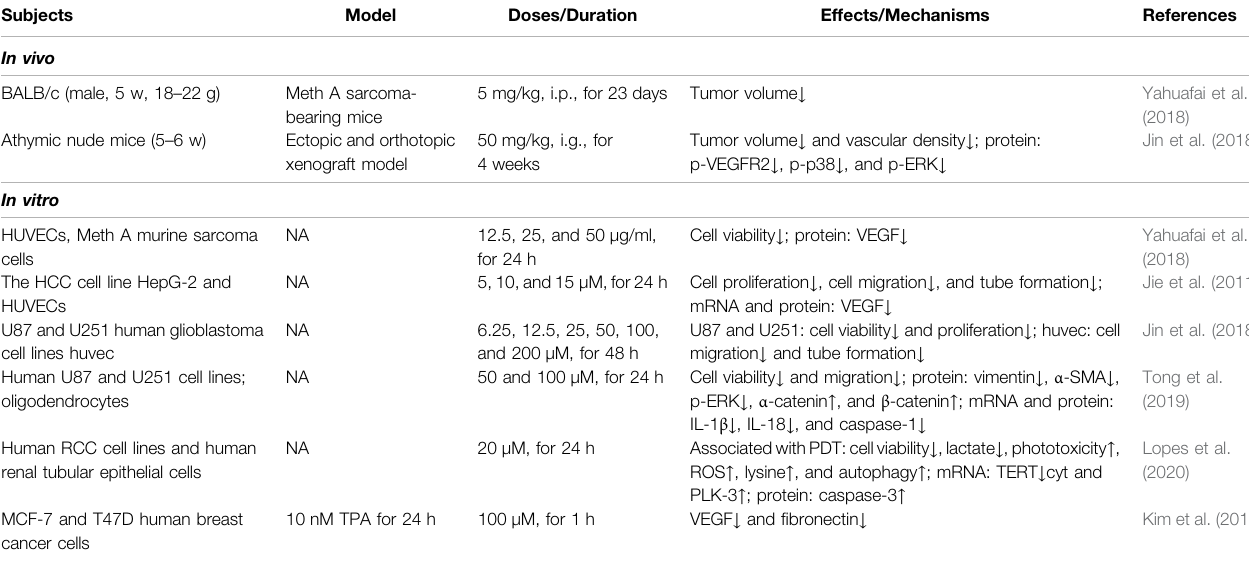
TABLE 7 | The in vivo and in vitro mechanism of berberine in the treatment of vasculature in